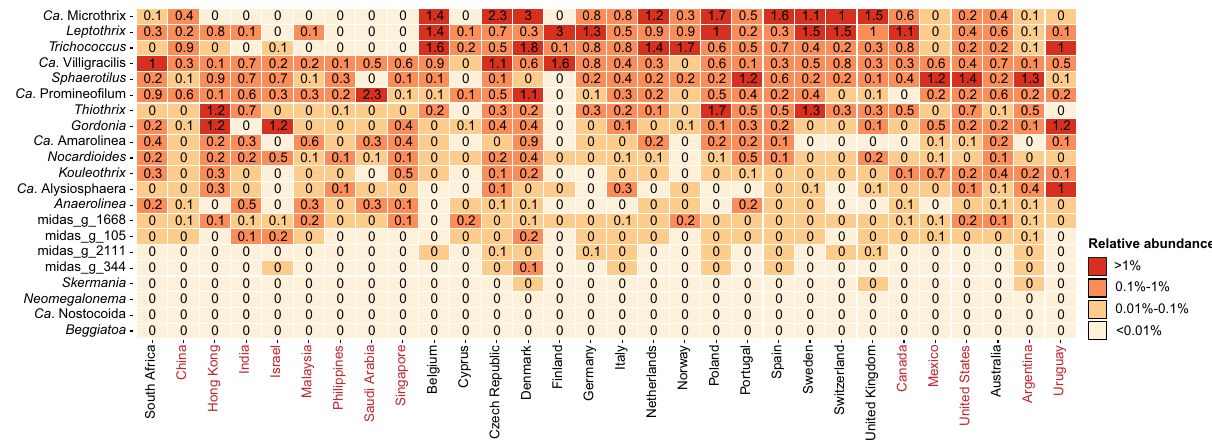
Fig. 9 Global diversity of known fi lamentous organisms. The percent relative abundance represents the mean abundance for each country across all process types. Countries are grouped based on the continent (shifting